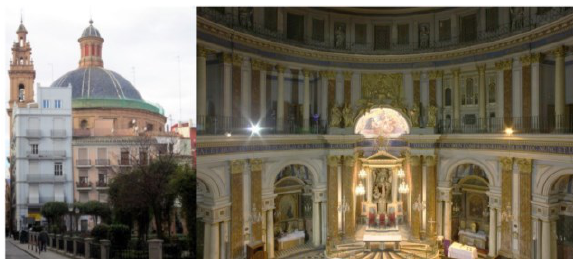
Figure 1. Iglesia de las Escuelas Pías (Valencia, Calle Carniceros, 2) Figure 3. The survey with laser scanner and thermal camera Global coordinates were not requested for this survey; therefore, no geodetic surveying was performed. In addition to the laser scanner acquisitions, 90 photos were taken in order to texture the 3D model.